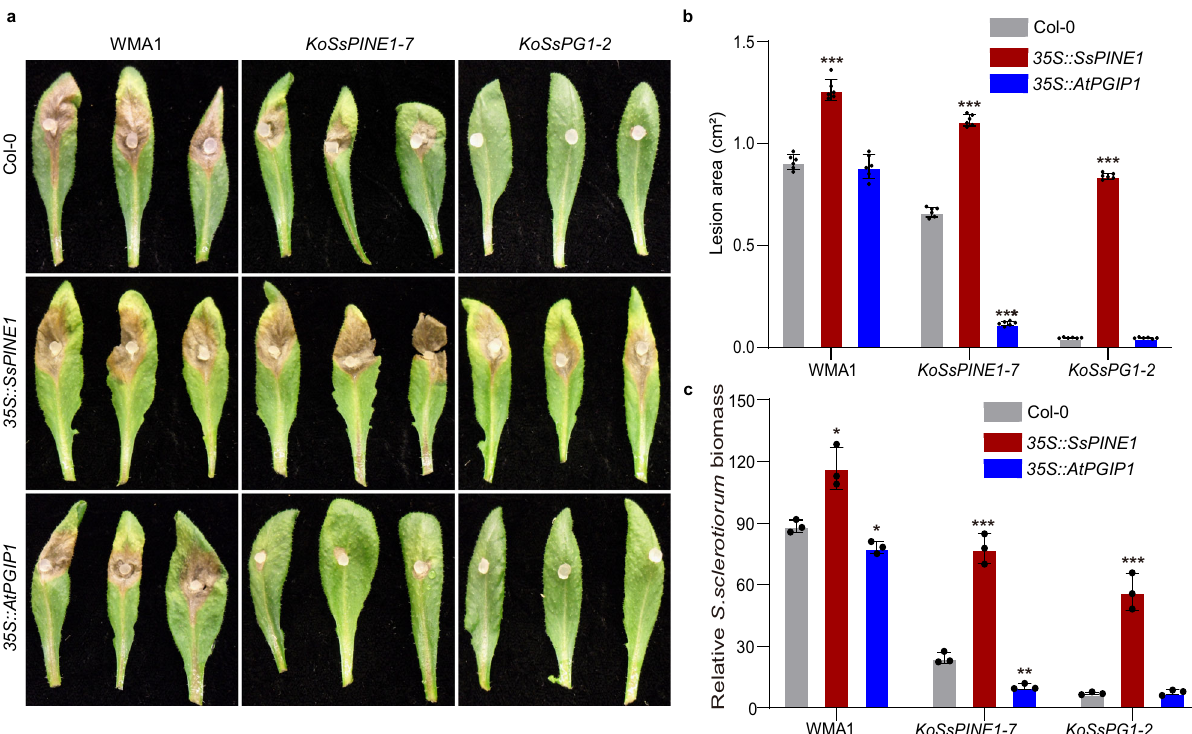
Fig. 6 Expression of SsPINE1 and AtPGIP1 in Arabidopsis altered plant response to Sclerotinia sclerotiorum infection. a Arabidopsis wild type Col-0, SsPINE1-GFP -expressing (35S::SsPINE1) and AtPGIP1-3xFlag -overexpressing (35S::AtPGIP1) lines were challenged with S. sclerotiorum WMA1, KOSsPINE1-7 and KOSsPG1-2 . Representative leaves were photographed 48 h post-inoculation. The experiment was repeated three times with similar results obtained. b Lesion area caused by WMA1, KOSsPINE1-7 and KOSsPG1-3 on Col-0, 35S::SsPINE1 and 35S::AtPGIP1 Arabidopsis lines at 48 hpi. Data represent means ± s.d. with n = 6 replicates, Treatment means are signi fi cantly different from that of the wildtype Col-0 at P < 0.001 (***) in two-stailed t tests. c Relative S. sclerotiorum biomass of WMA1, KOSsPINE1-7 and KOSsPG1-3 on Col-0, 35S::SsPINE1 and 35S::AtPGIP1 Arabidopsis lines at 48 hpi, measured by genomic DNA quantitative PCR. Data represent means ± s.d. with n = 3 replicates, Treatment means are signi fi cantly different from that of the wildtype Col-0 at P < 0.05 (*), 0.01 (**) or 0.001 (***), respectively, in two-tailed t tests. The experiment was performed three times with similar results obtained. Source data are provided as a Source data fi (Fig. 6b, c). The most dramatic increase in lesion area and relative Sclerotinia biomass was observed when inoculated with the Δ SsPG1 mutant (Fig. 6b, c), which suggests that overexpression of